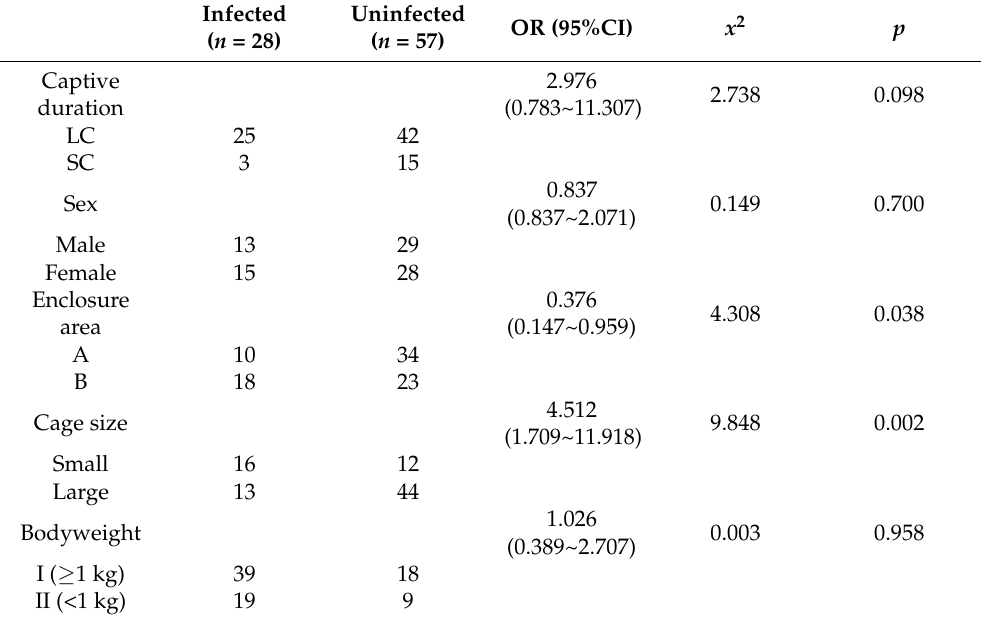
Table 3. The Chi-square test and OR values showed the effects of confinement duration, sex, enclosure area, cage size, and bodyweight on the prevalence and subtype distribution of Blastocystis in N. bengalensis in